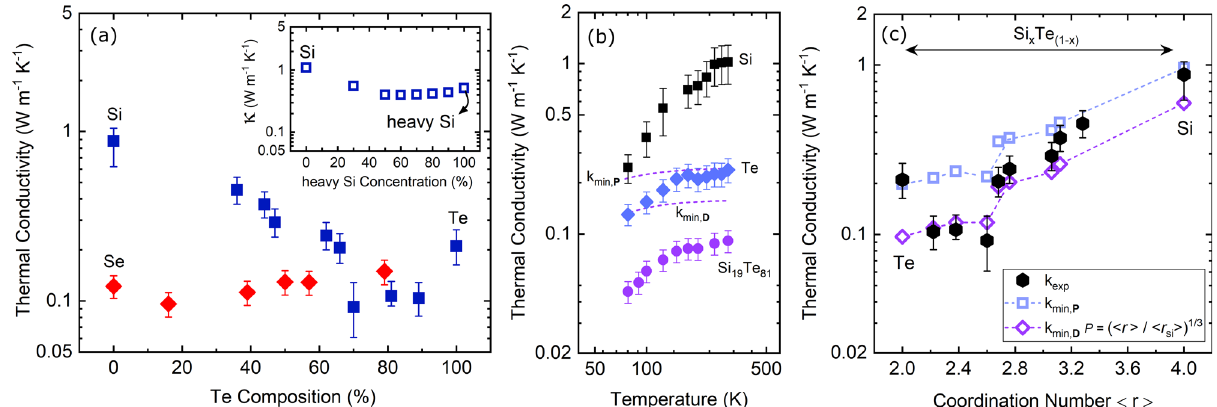
Fig. 2 Thermal conductivity experimental results and the corresponding models. a The measured thermal conductivity as a function of tellurium concentration in amorphous SiTe (solid squares) and SeTe (solid diamonds). The inset shows the NEMD simulation results for thermal conductivity of Si (28 u), heavy-Si (127 u), and their alloy. b Thermal conductivity of amorphous silicon (solid squares), tellurium (solid diamonds), Si 19 Te 81 (solid circles), and minimum limit models for Si 19 Te 81 (dashed line) as a function of temperature. c Thermal conductivity of SiTe as a function of coordination number measured by TDTR (solid hexagons), their corresponding phonon-mediated (hollow squares), and the diffuson-mediated (hollow diamonds) minimum limit approximations. Uncertainties are calculated based on 10% variations in the thickness of SiTe fi